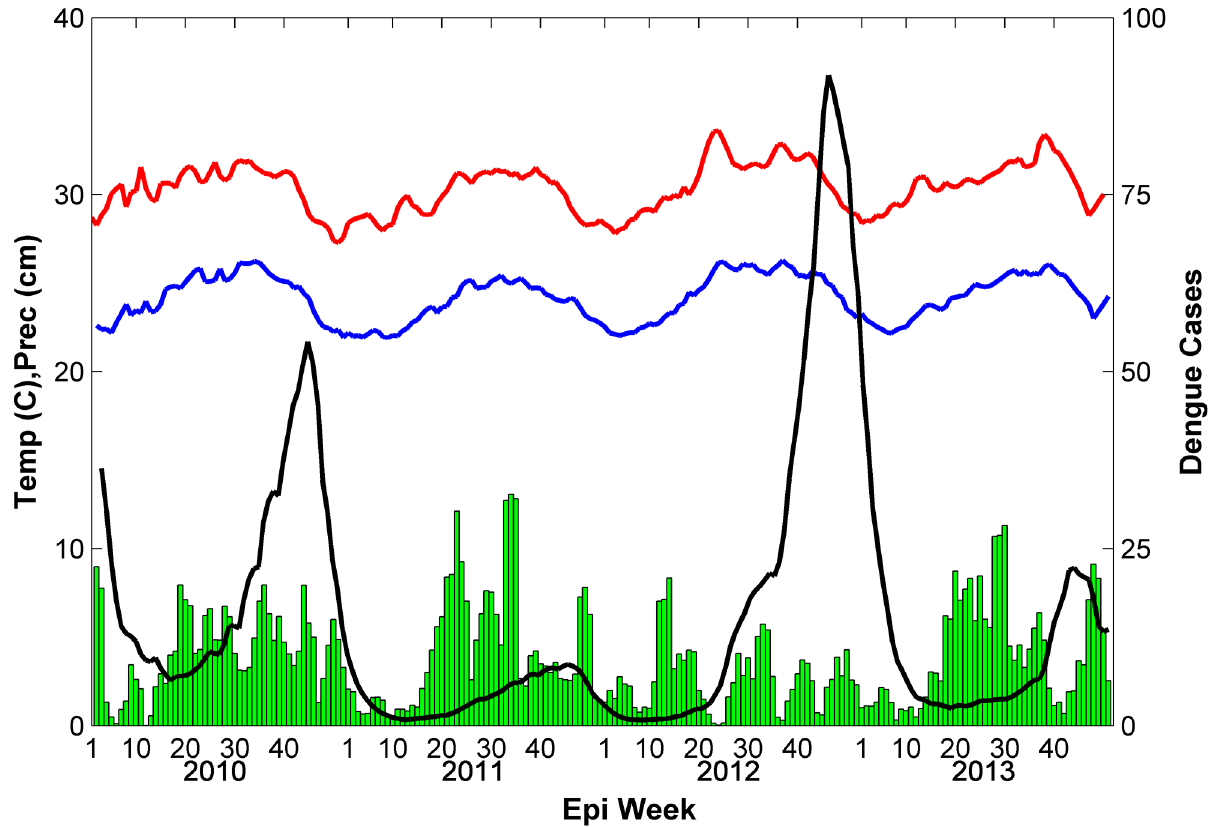
Fig 6. Weekly summarized climate and simulated DF cases over San Juan, 2010 – 2103. The green bars are weekly total precipitation, the red line is weekly mean maximum temperature, the blue line is weekly mean minimum temperature, and the black line is weekly total simulated DF cases.